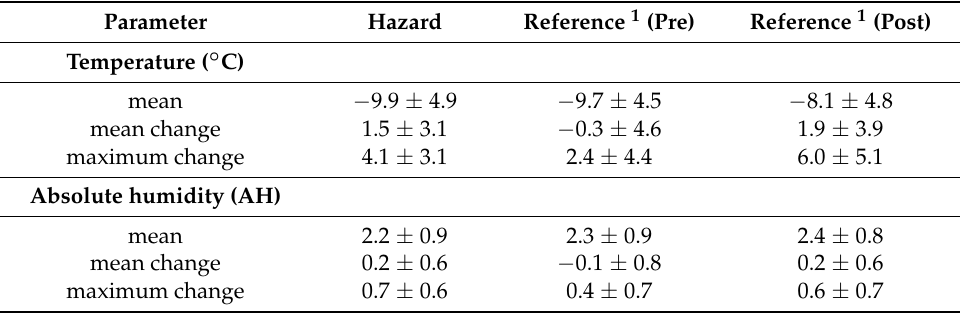
Table 1. Mean and maximal decline in temperature and absolute humidity (AH) during the hazard period ( n = 146) prior to the onset of rhinovirus infections and during the reference periods. Values represent mean ± standard deviation (SD).